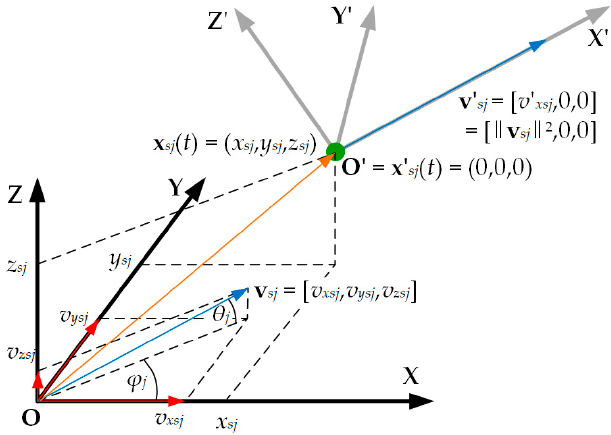
Figure 3. Transformation of the coordinate system relative to the sensor position and the direction of its velocity vector.